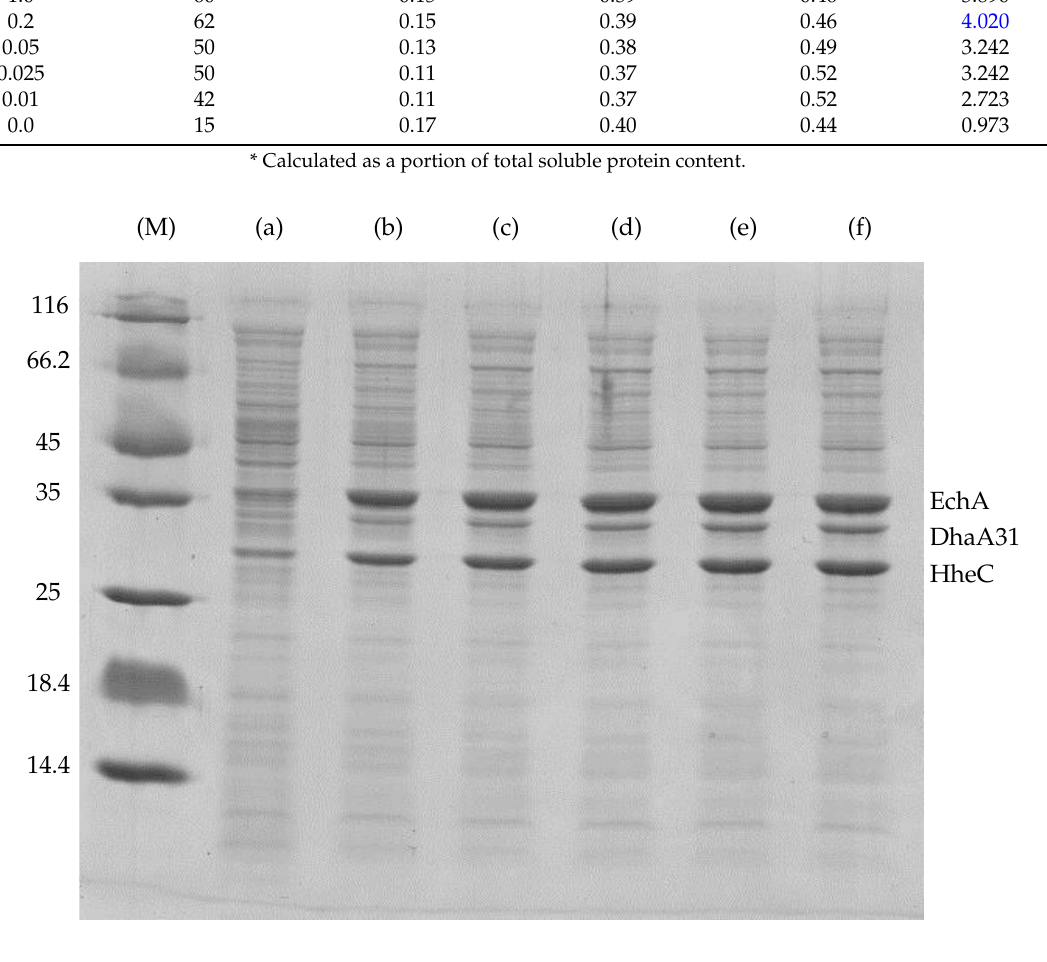
Figure A1. Sodium dodecyl sulfate polyacrylamide gel electrophoresis of cell-free extracts obtained from E. coli deg31 cells induced with various concentrations of IPTG (( M ) protein marker (116, 66.2, 45, 35, 25, 18.4, and 14.4 kDa)): ( a ) 0.0 mM IPTG; ( b ) 0.01 mM IPTG; ( c ) 0.025 mM IPTG; ( d ) 0.05 mM IPTG; ( e ) 0.2 mM IPTG; and ( f ) 1.0 mM IPTG. Bands of DhaA31 (34 kDa), HheC (29 kDa) and EchA (35 kDa) are